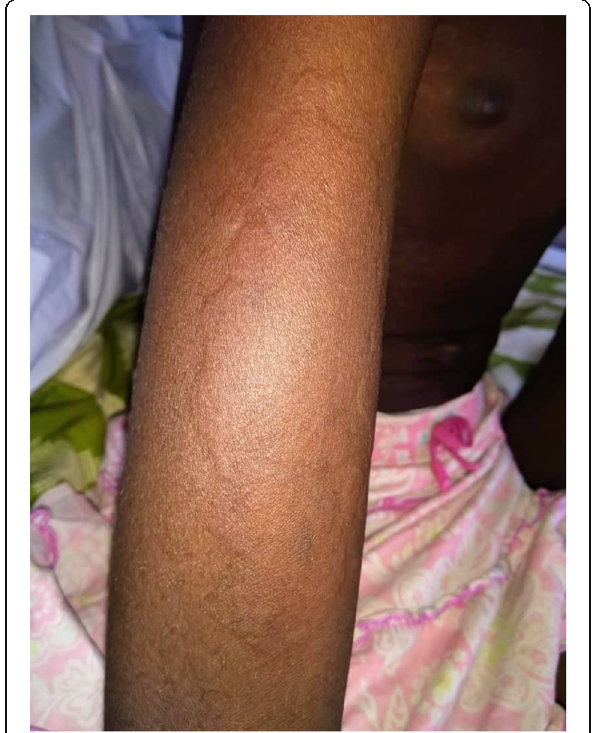
Fig. 1 Skin eruptions on the extensor surface of the right arm showing plaques and coalesced lesions with raised